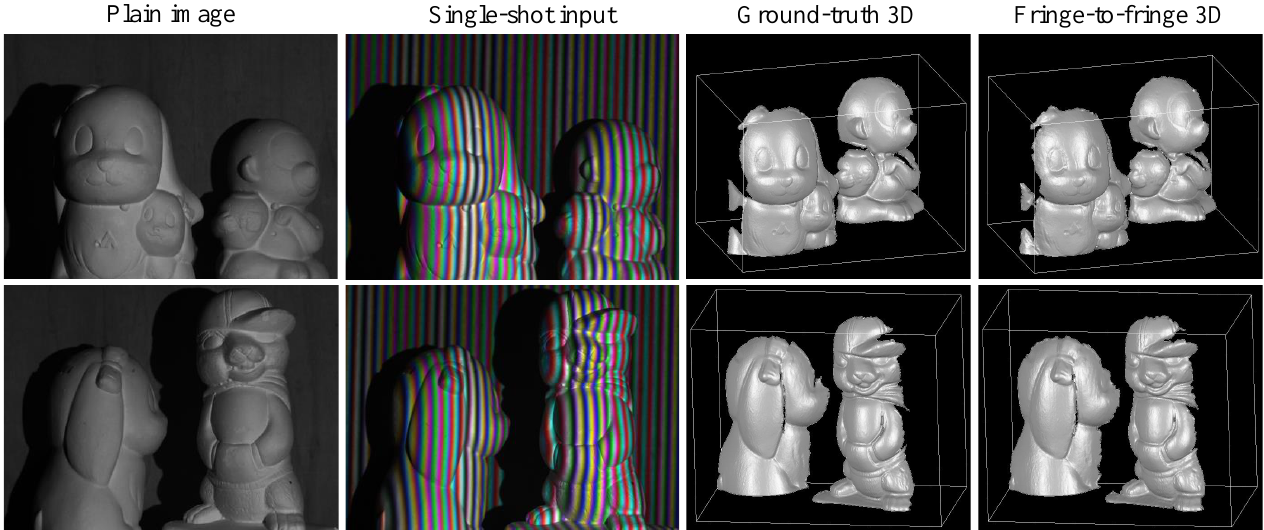
Figure 8. 3D shape reconstruction of multiple separated objects with complex